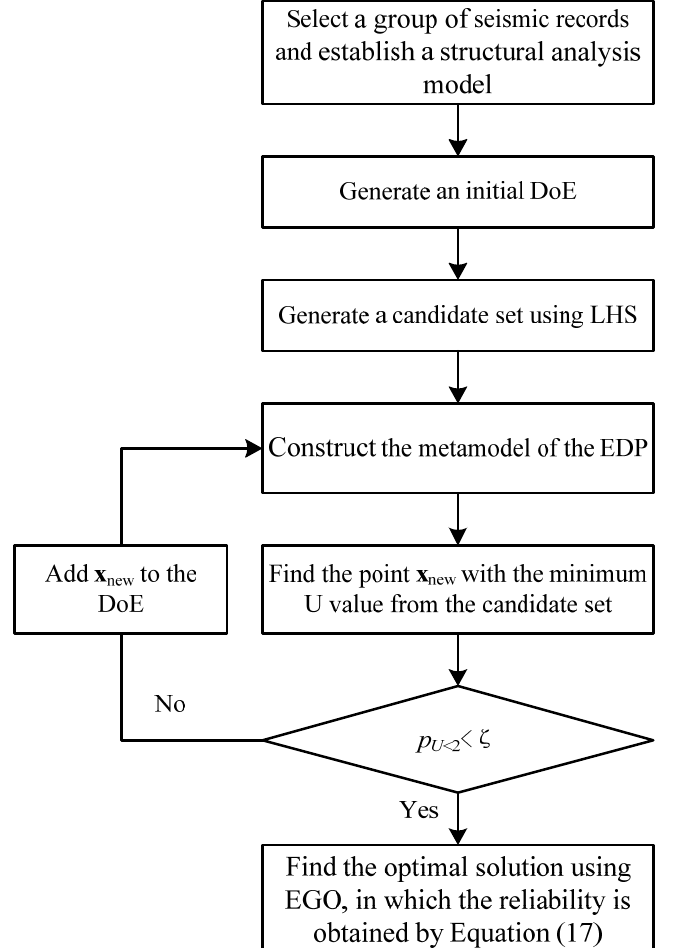
Figure 2. Flowchart of RBDO.